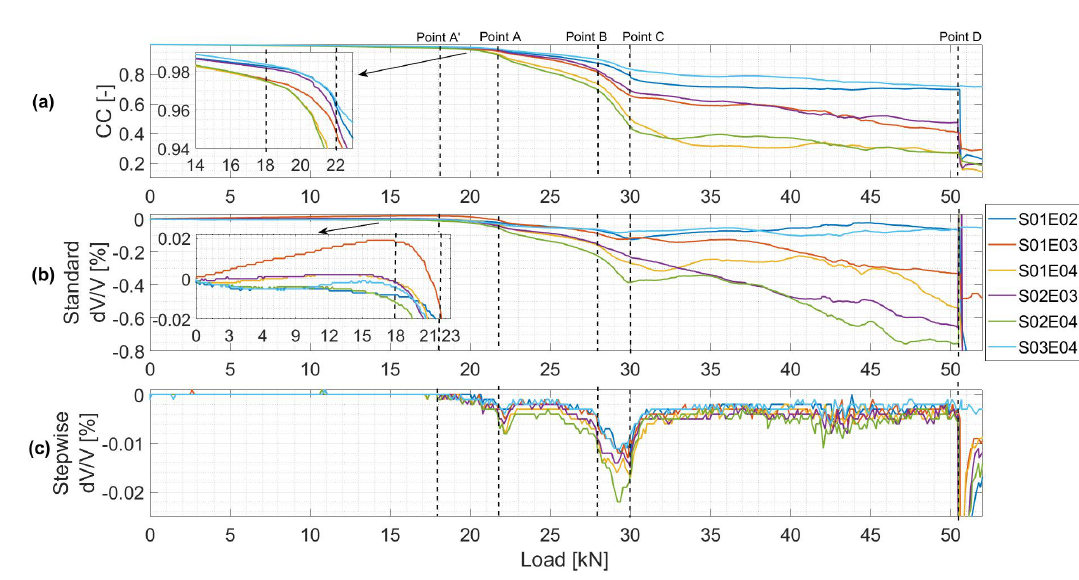
Figure 9. (a) CC plots for each SxxEyy combination. (b) dV / V plots for each SxxEyy combination. (c) Stepwise dV / V plots for each SxxEyy